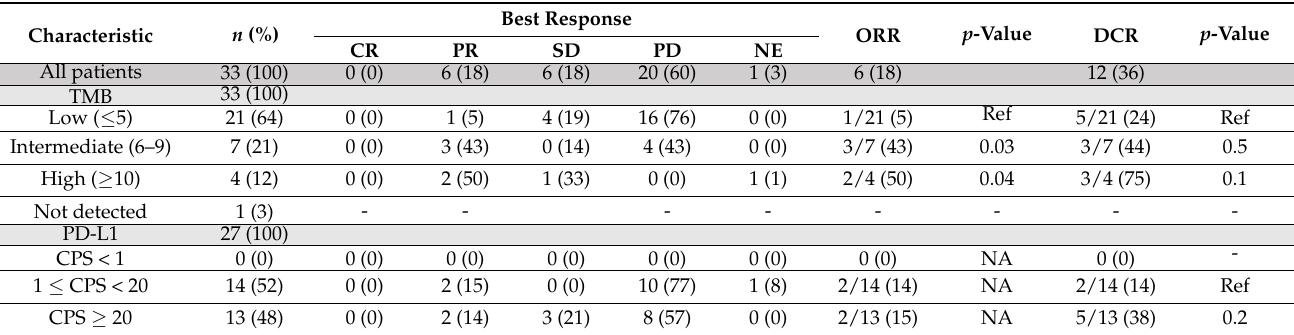
Table 2. Responses to ICI in patients with SCC.